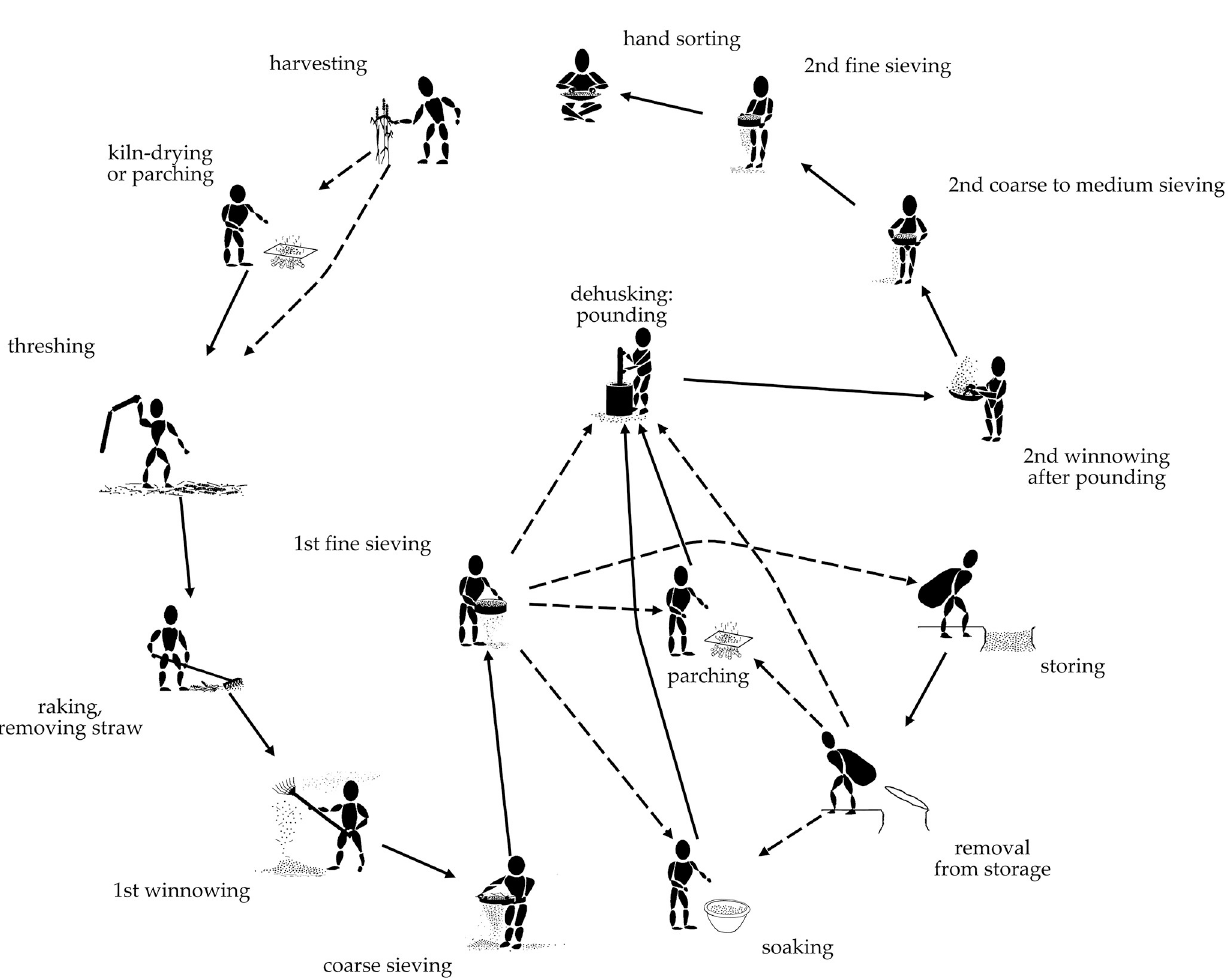
Fig 5. Illustration of a chaîne opératoire for crop processing using the example of hulled wheats. The sequence starts on top with the cereal plant, proceeding counter-clockwise towards “ready-to-cook” grains. Ramifications (optional steps) in dashed lines. Illustration basing on the original design by Stevens [54], additional steps such as harvesting, kiln-drying, storing, and parching/soaking prior to dehusking were added [65, 72, 73]. Image from Heiss [48].